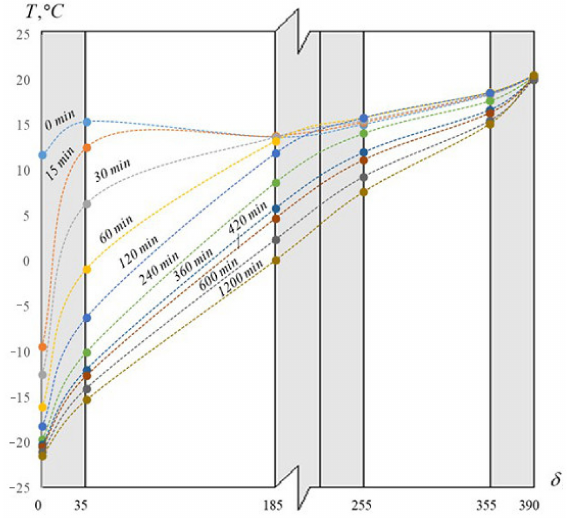
Figure 7. Change of isotherms in time to a stationary